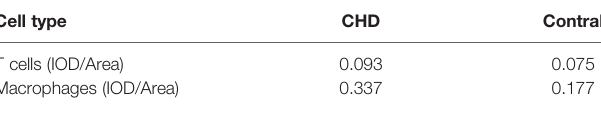
TABLE 5 | The semi-quanti fi cation analysis of in fi ltrating immune cell. Cell